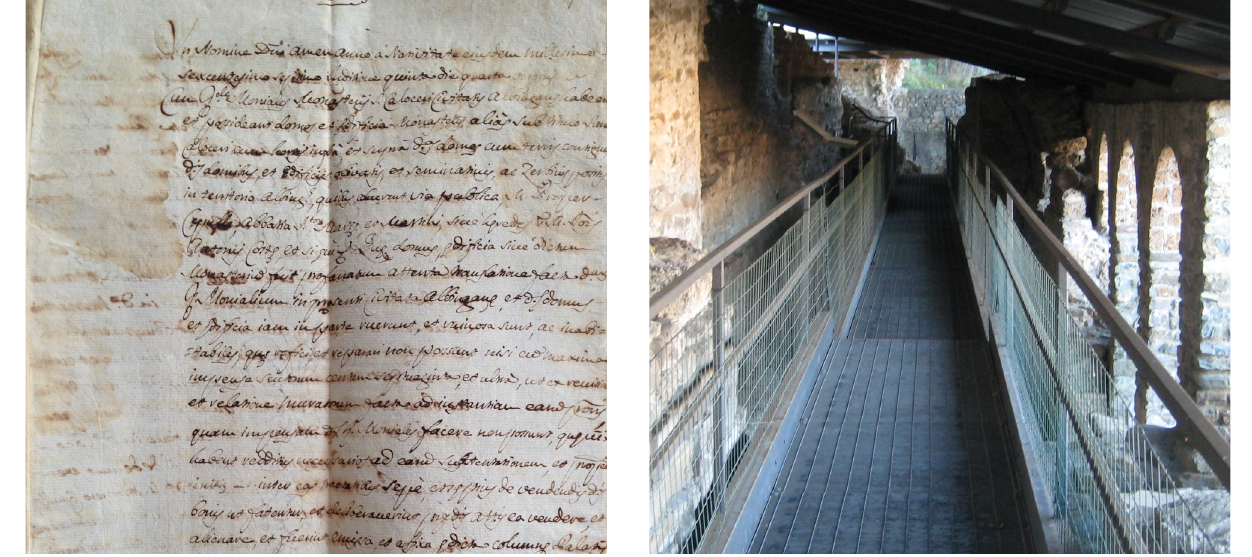
Figure 9. San Calocero, ‘criptoportico’ (January 2017 by Chiara